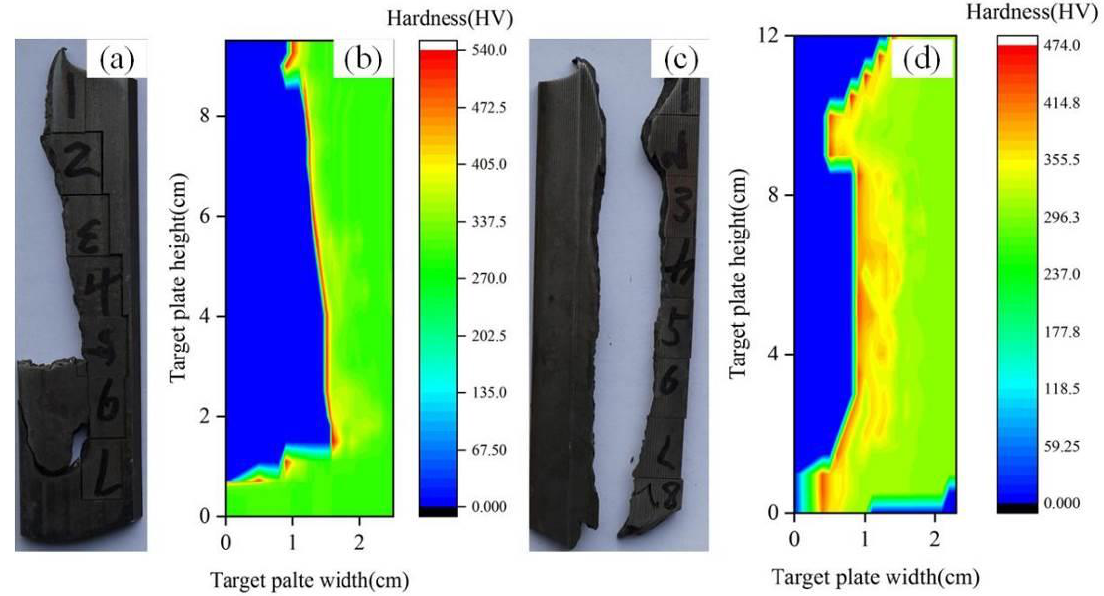
Figure 10. Target hardness distribution. ( a ) The 93W crater, ( b ) hardness distribution of the 93W crater, ( c ) Wf/Zr-MG crater, and ( d ) hardness distribution of the Wf/Zr-MG crater.